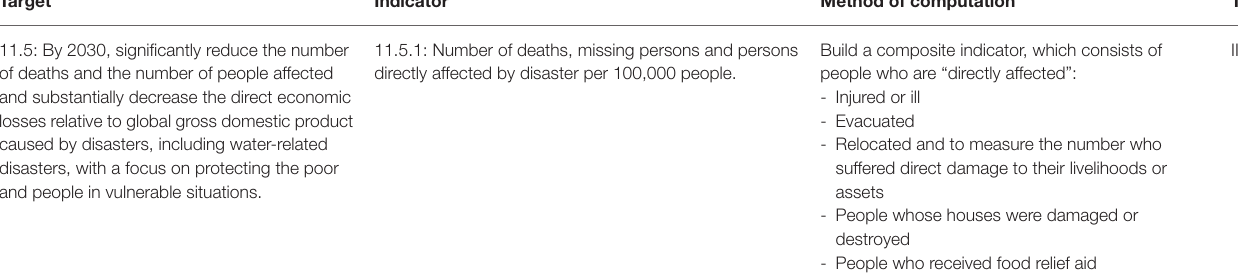
Target Indicator Method of computation